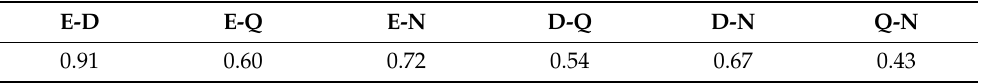
Table 3. Correlation between the tweeting pattern of four kinds of reaction towards unverified